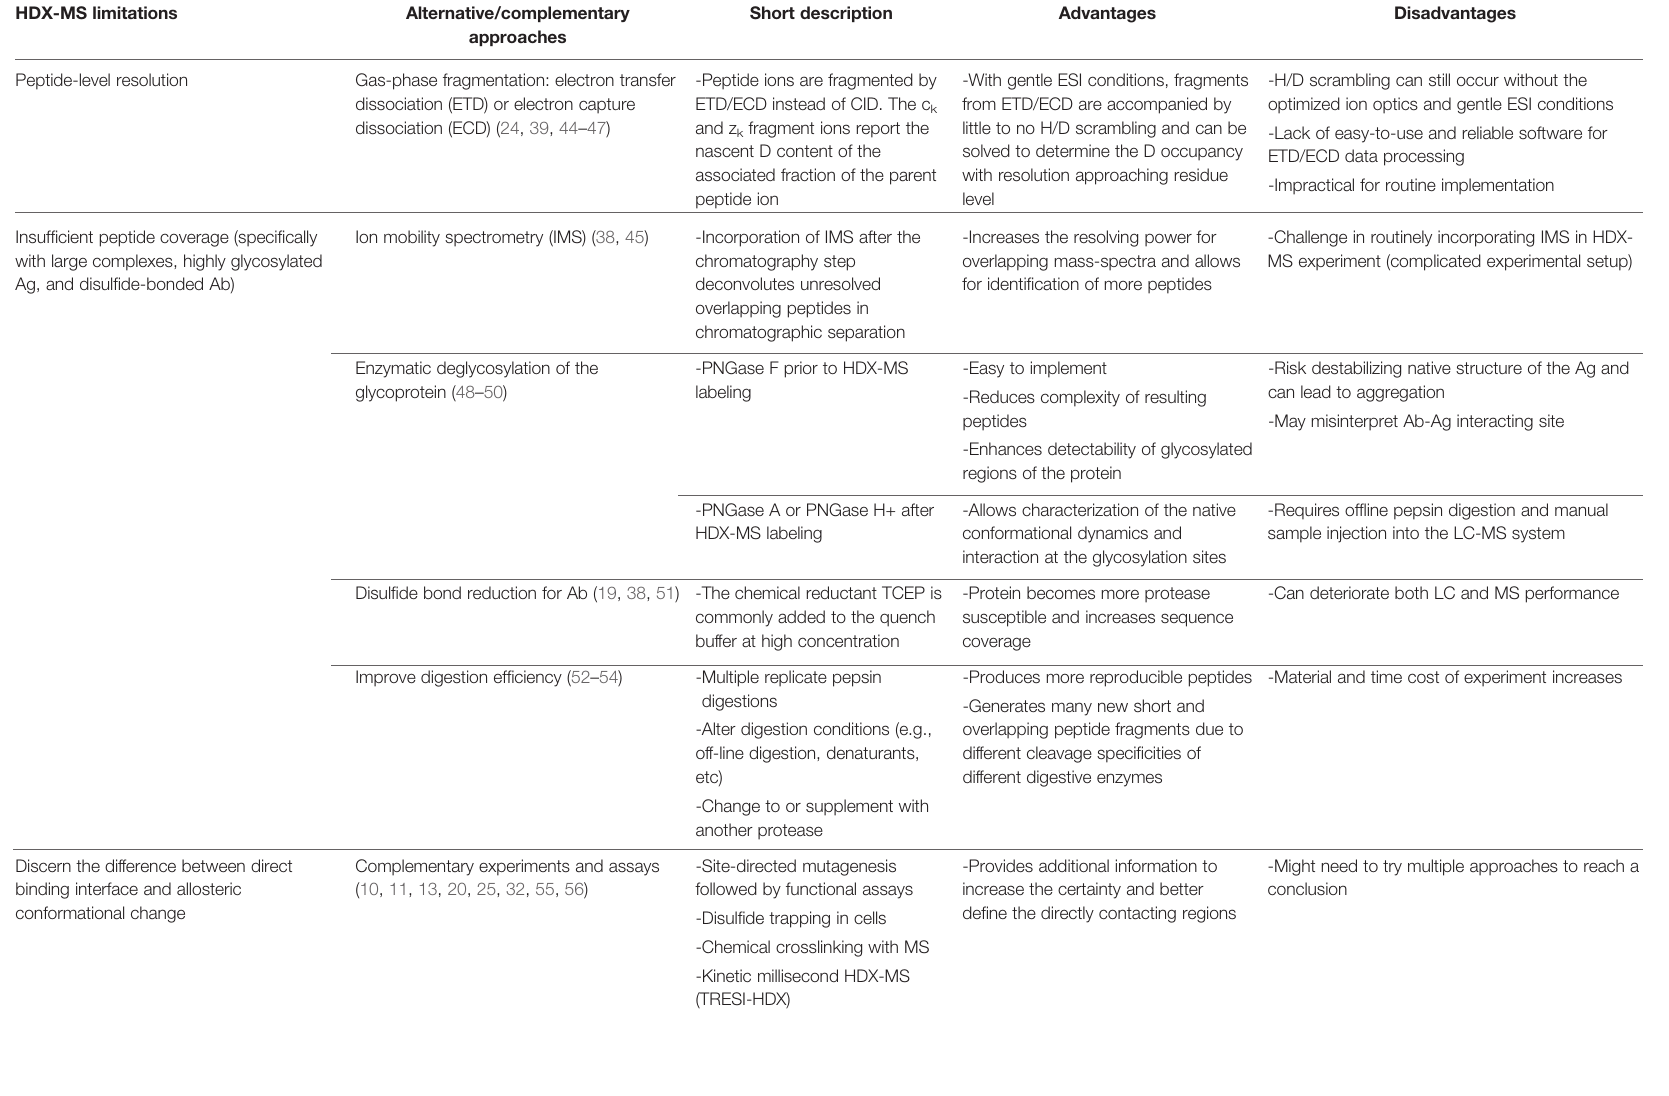
TABLE 1 | Current alternative or complementary experimental approaches and their pros and cons regarding each HDX-MS experimental